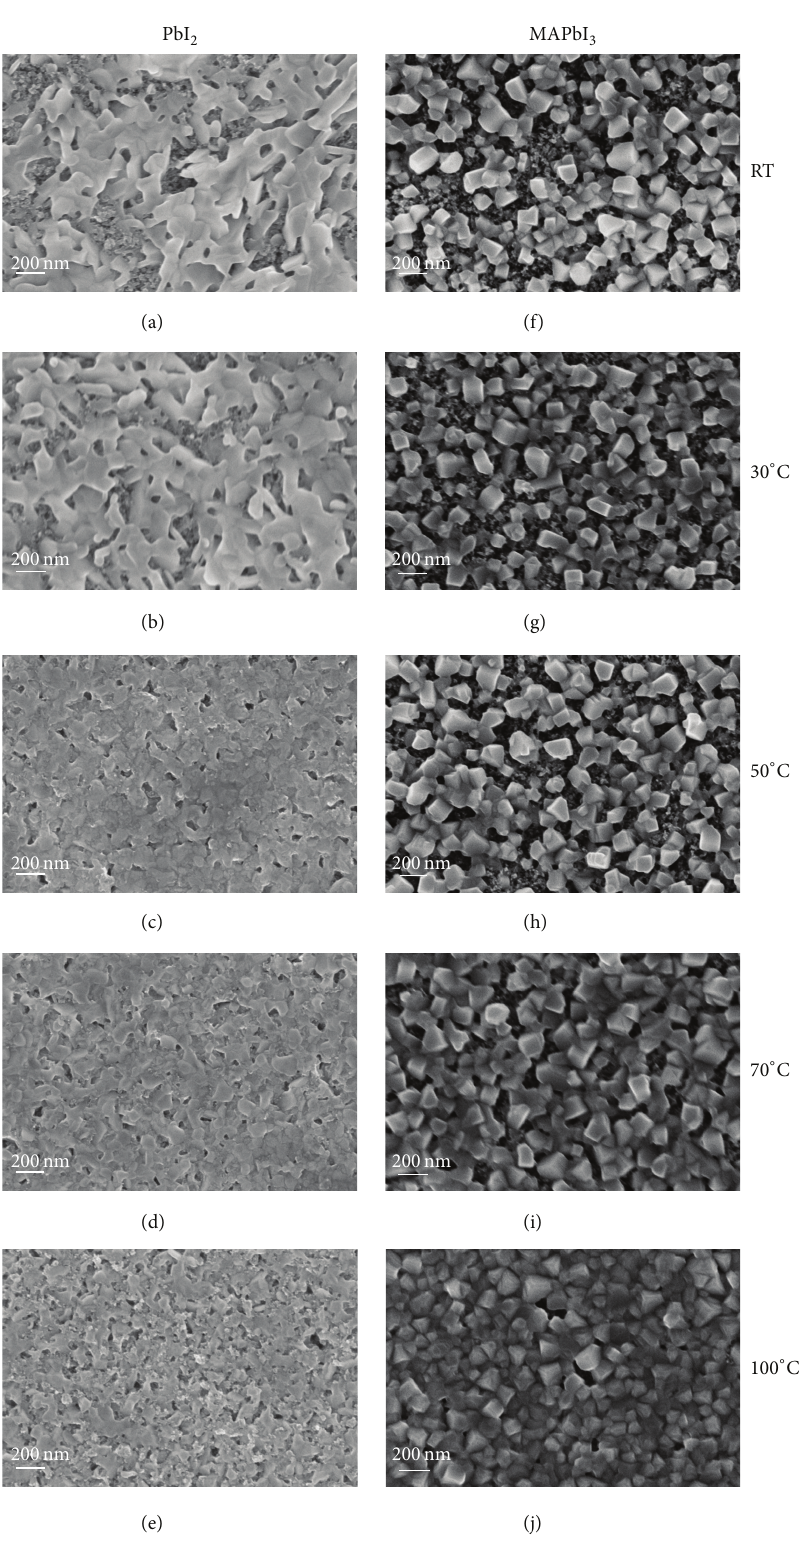
Figure 2: Top-view SEM images of the PbI 2 layers deposited on the mp-TiO 2 coated FTO substrate, where the substrate was preheated at (a) RT (without preheating), (b) 30 ∘ C, (c) 50 ∘ C, (d) 70 ∘ C, and (e) 100 ∘ C. The MAPbI 3 thin film layers (f–j) correspond to the PbI 2 layers deposited on the different preheating